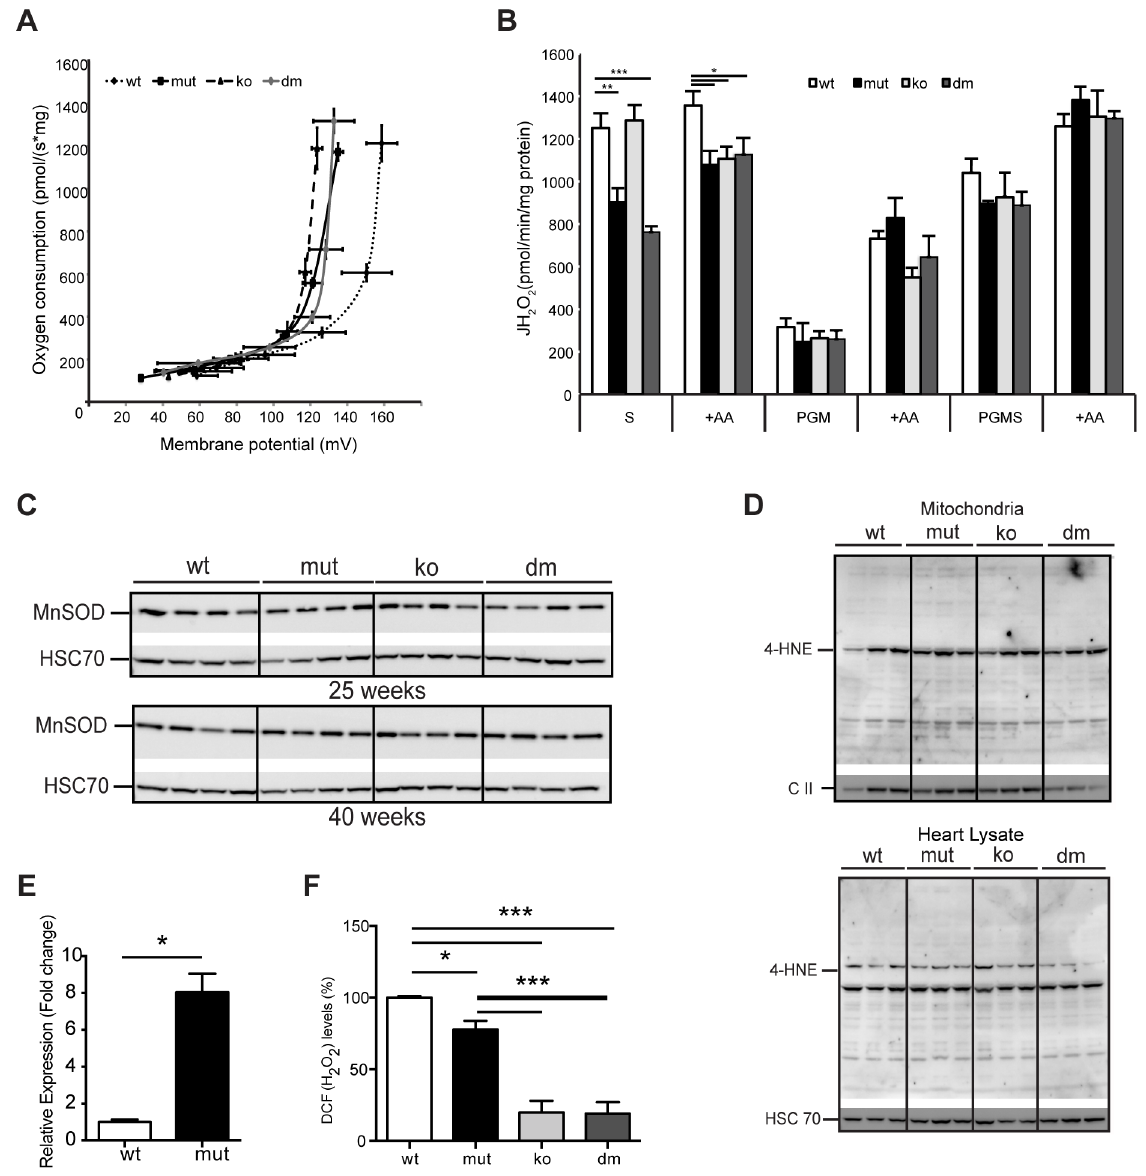
Figure 4. UCP2 deficiency does not affect proton leak kinetics or ROS production. (A) Flow-force relationship in heart mitochondria of 25- week-old wild type (wt), mtDNA mutator (mut), UCP2-deficient wild type (ko) and mtDNA mutator (dm) mice examined in the presence of succinate and increasing amounts of malonate (n=6). Data points indicate mean levels 6 standard error of the mean (S.E.M.). (B) Hydrogen peroxide production rate in heart mitochondria in the presence of succinate (S); Pyruvate-Glutamate-Malate (PGM) or Pyruvate-Glutamate-Malate-Succinate (PGMS) as substrates. Measurement in the presence of succinate alone detects reverse flow ROS production from both Complex I and Complex III. When mitochondria are incubated in the presence of pyruvate-glutamate-malate (PGM), the ROS production mainly originates from complex III and therefore it is usually lower. Treatment with Antimycin A ( + AA), an inhibitor of CO III, was used as a positive control, to further induce ROS production (n=4–5). Bars indicate mean level 6 standard error of the mean (S.E.M.). (C) Western blot analyses of Manganese Superoxide Dismutase (MnSOD) in heart lysates of 25- and 40-week-old mice (n=4). (D) Analysis of 4-Hydroxynonenal as measure for oxidative stress induced lipid peroxidation in isolated mitochondria (upper panel) and tissue lysates (lower panel) of 25-week-old mouse hearts. The mitochondrial Complex II 70 kDa protein (C II) was used as loading control in isolated mitochondria and the Heat shock 70 kDa protein 8 (HSC 70) in heart tissue lysates (n=4). (E) Fold change of Ucp2 transcript levels in primary MEFs (P1–P3). (F) ROS production in intact cells was assessed by flow cytometric analyses of primary (passage 1–3) mouse embryonic fibroblasts (MEFs) stained with CM-H 2 DCFDA that upon oxidation by ROS, particularly hydrogen peroxide (H 2 O 2 ) and the hydroxyl radical ( ? OH), yields the fluorescent DCF product. Data are expressed as median values of fluorescence intensity 6 standard error of the mean (S.E.M.). Asterisks indicate level of statistical significance (*p , 0.05 **p , 0.01 ***p , 0.001, Student’s t -test).